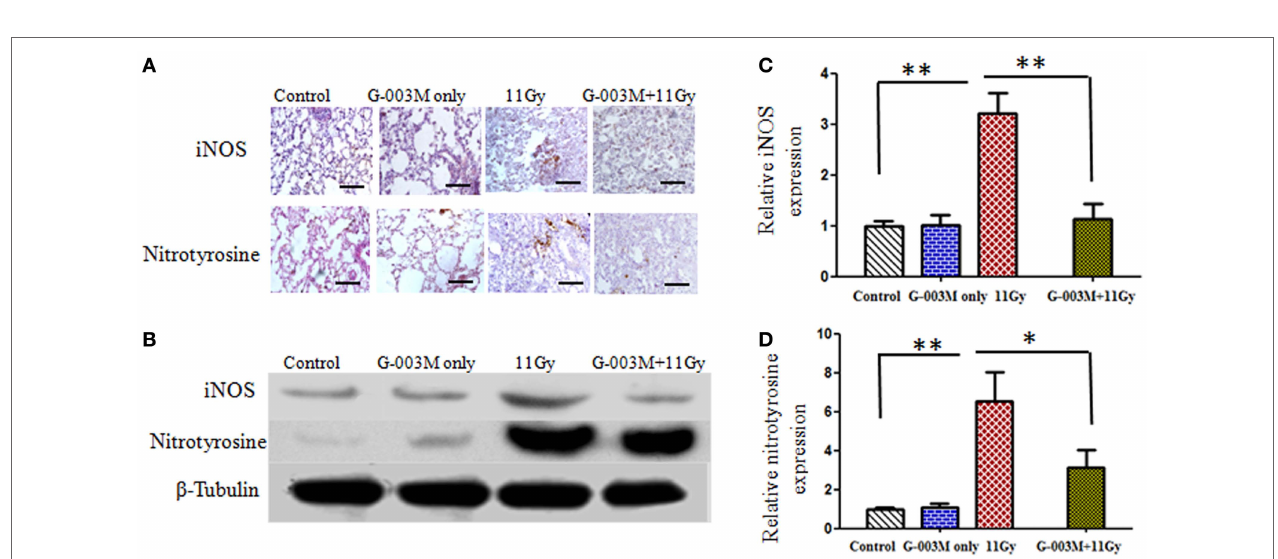
FigUre 3 | Effect of G-003M on nitrosative stress in 11 Gy thoracic-irradiated lungs. (a) Immunohistochemical expression of inducible nitric oxide synthase (iNOS) and nitrotyrosine in lungs of differentially treated mice (200 × ). (B) Western blotting of iNOS and nitrotyrosine in lungs at 8 weeks postirradiation treatment. Densitometry analysis represents iNOS (c) and nitrotyrosine (D) expression normalized to β -tubulin. Scale bar 100 µm. Data are represented as means ± SEM from six mice for each group. * p < 0.01, ** p < 0.001.